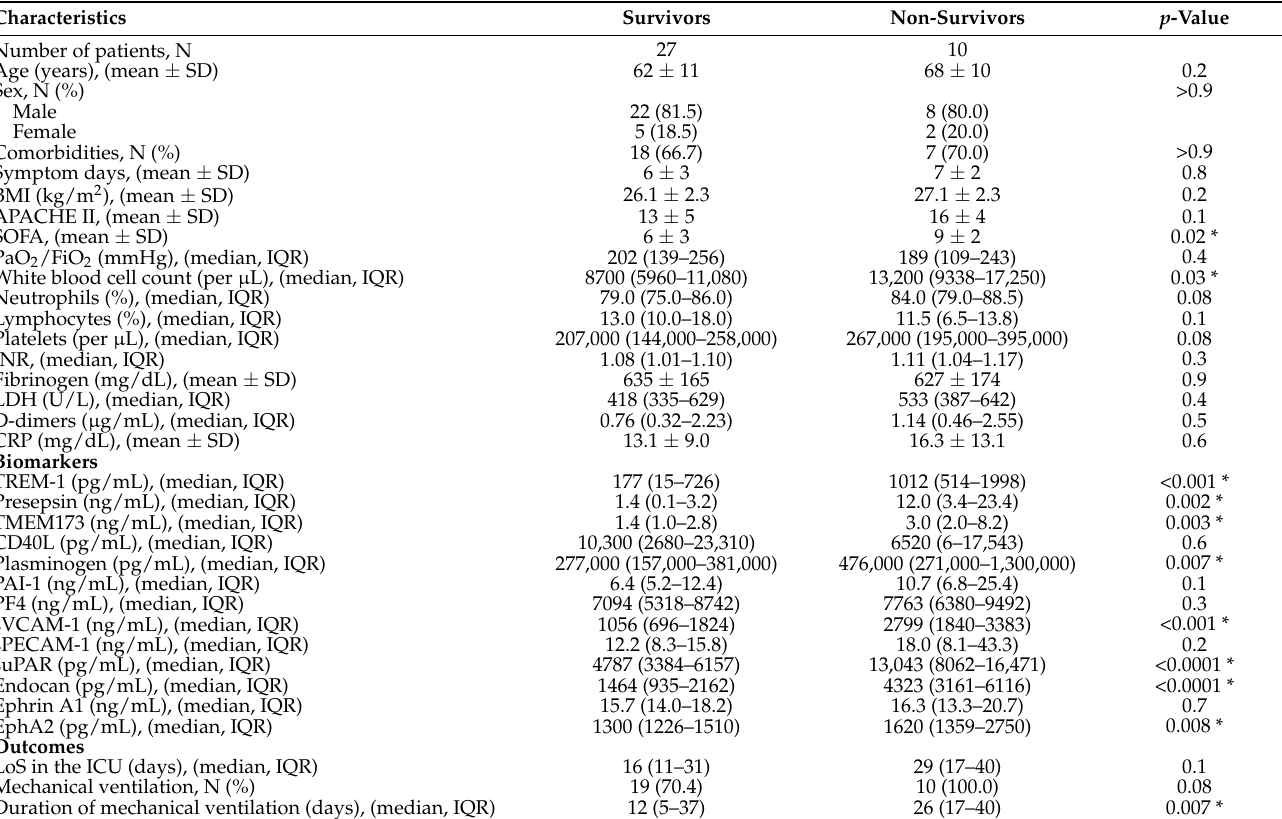
Table 2. Demographics, clinical characteristics and biomarkers on ICU admission in the dexamethasone-free group. Characteristics